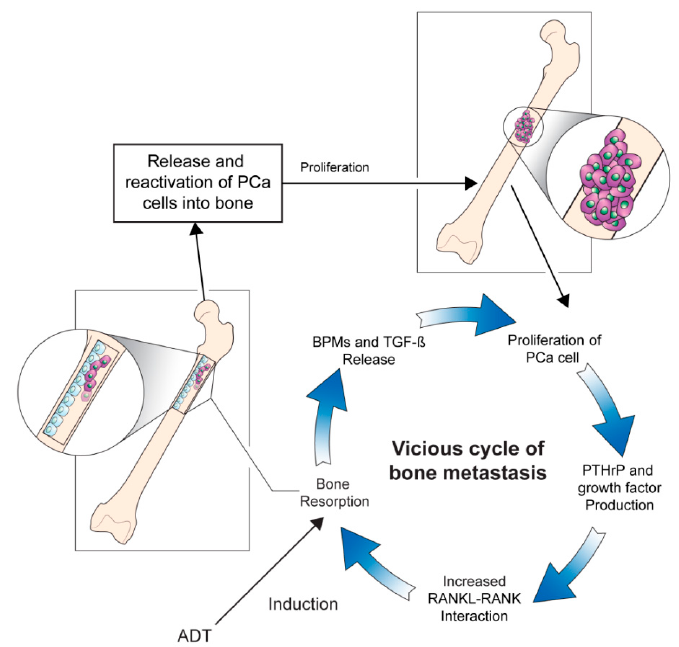
Figure 1. The vicious cycle of bone metastasis. Bone resorption releases and reactivates PCa cells into the bone, leading to metastatic outgrowth in the bone microenvironment. Production of factors by PCa cells that increase bone resorption through enhanced interaction between RANKL expressing osteoblasts and RANK expressing osteoclasts mediates the vicious cycle of PCa bone metastasis. Production of PTHrP and growth factors increases the interaction between RANKL-expressing osteoblasts and RANK-expressing osteoclasts, which further increases bone resorption. The release of BMPs and TGF- β by bone resorption further aggravates the vicious cycle. ADT: androgen-deprivation therapy, BMPs: bone morphogenetic proteins, PCa: prostate cancer, PTHrP: parathyroid hormone-related protein, RANK: receptor activator of nuclear factor- ĸβ , RANKL: receptor activator of nuclear factor- ĸβ ligand, TGF- β : transforming growth factor- β .